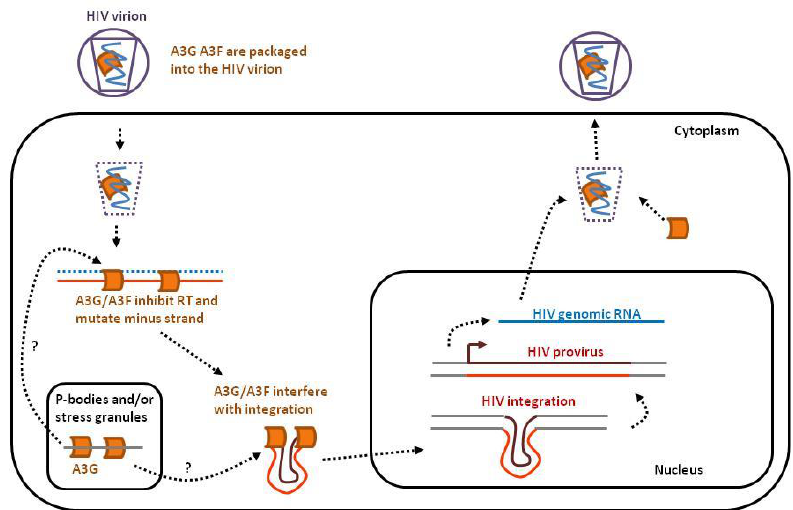
Figure 1. APOBEC3s interfere with several key steps of the HIV infectious cycle. After binding of the HIV virion to the cell membrane, the single-stranded RNA genome ( in blue ) is released into the cytoplasm together with APOBEC3G and 3F ( orange ). APOBEC3 proteins expressed by the host cell concentrate in P-bodies and stress granules. A3G and A3F inhibit reverse transcription, mutate viral DNA and perturb proviral integration into the host genome. In the absence of HIV Vif, A3G and A3F will be incorporated into the budding virions.